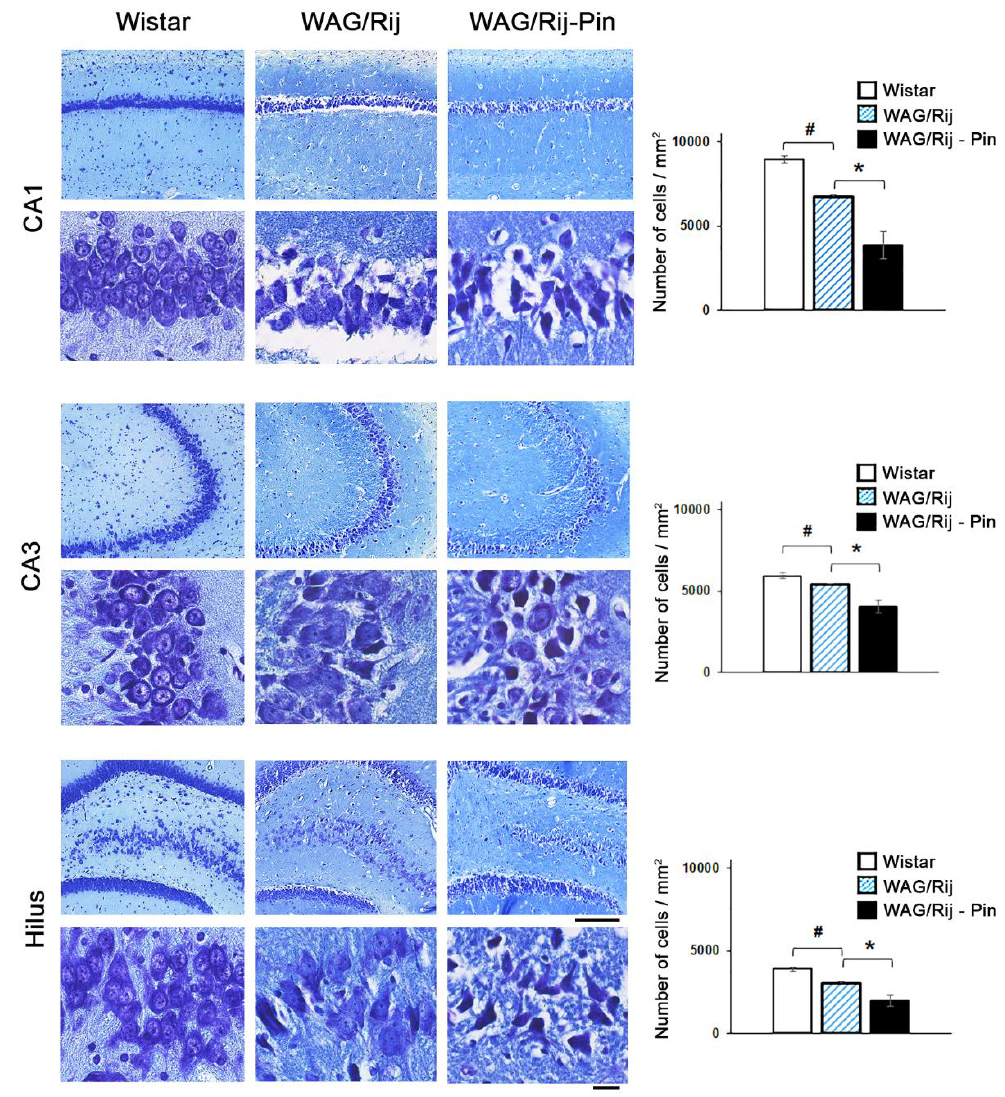
Figure 3. Cell density in the hippocampus of Wistar and WAG/Rij rats, and effects of pinealectomy in WAG/Rij rats. Representative Nissl-stained sections of CA1, CA3 and Hilus are shown on the left. Scale bars: 200 µm for 10× and 20 µm for 60×. Values of cell densities are means ± S.E.M. for Wistar-Naive; WAG/Rij-Sham, and WAG/Rij-Pin. p < 0.05 between intact WAG/Rij and Wistar rats (#), or between WAG/Rij-Pin versus WAG/Rij-Sham rats (*). Statistical analysis was performed with the Mann–Whitney U test.